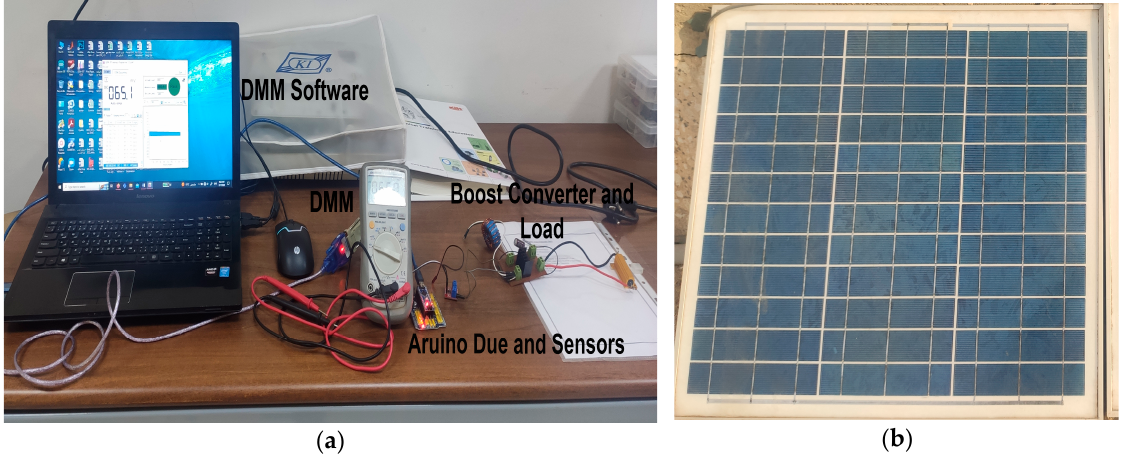
Figure 16. ( a ) Hardware Implementation and ( b ) PV module.